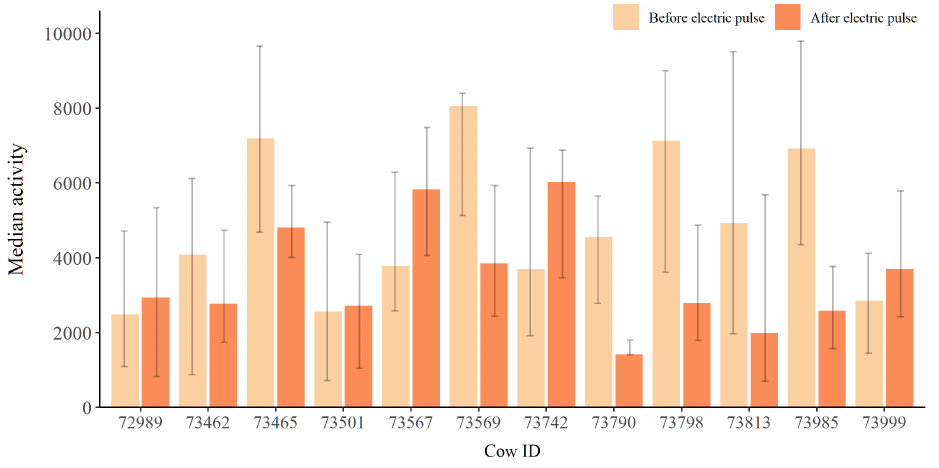
Figure 6. Median activity of each individual two hours before and after receiving an electric impulse ( n = 202). Error bars represent the interquartile